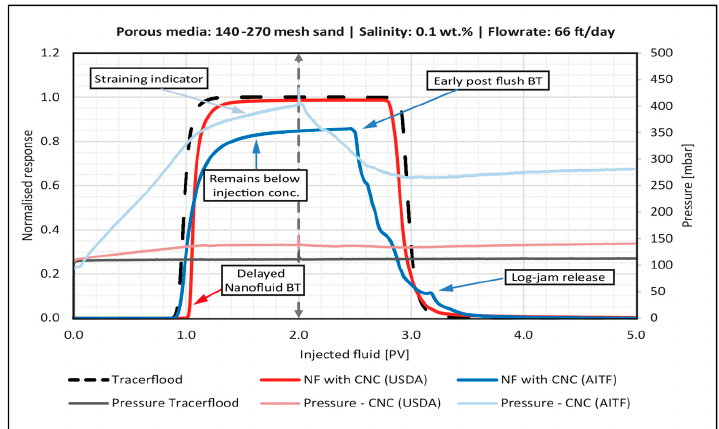
Figure 9. Breakthrough curve for the sandpackflood with 0.5 wt. % CNC (USDA) (red line) and 0.5 wt. % CNC (AITF) blue line. Dashed vertical line illustrates the switch to post flush fluid. The tracer BT-curve is the black dotted line.